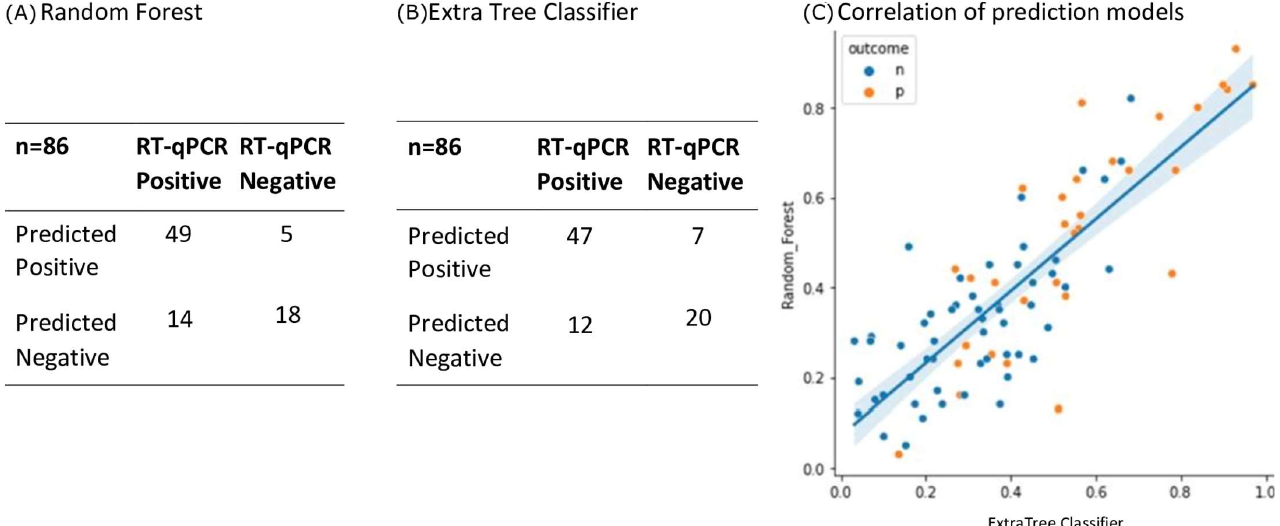
protein fragment 1; S2—Spike protein fragment 2